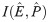
Graphical illustration of the three axioms.Elite nodes are gray. (A1) The elite’s external influence (blue edges), I(E^,P^), dominates the periphery’s internal influence (black edges), I(P^,P^). (A2) The internal influence of the elite, I(E^,E^), is robust to the periphery’s external influence, I(P^,E^). (A3) The elite is denser and its average individual is more powerful than an average individual in the society.